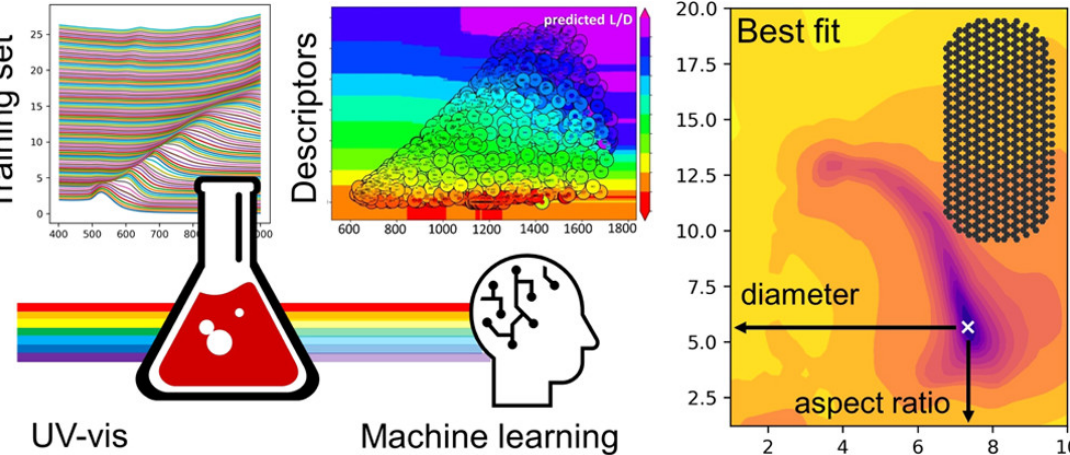
Figure 7. ML-assisted quantitative analysis of optical spectra of gold nanoparticles (Reproduced with permission from the American Chemical Society) [87].